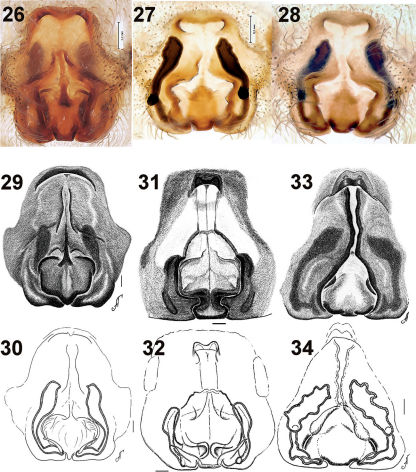
Epigyne of Acantholycosa azarkinae sp. n. (26–28), Acantholycosa oligerae (29–30), Acantholycosa norvegica (31–32) and Acantholycosa lignaria (33–34). 26, 28–29, 31, 33 epigyne, ventral 27, 30, 32, 34 vulva, dorsal. 27–28, 30, 32, 34 after maceration. 29–34 after Marusik et al. (2004). Scale = 0.1 mm if not otherwise indicated.